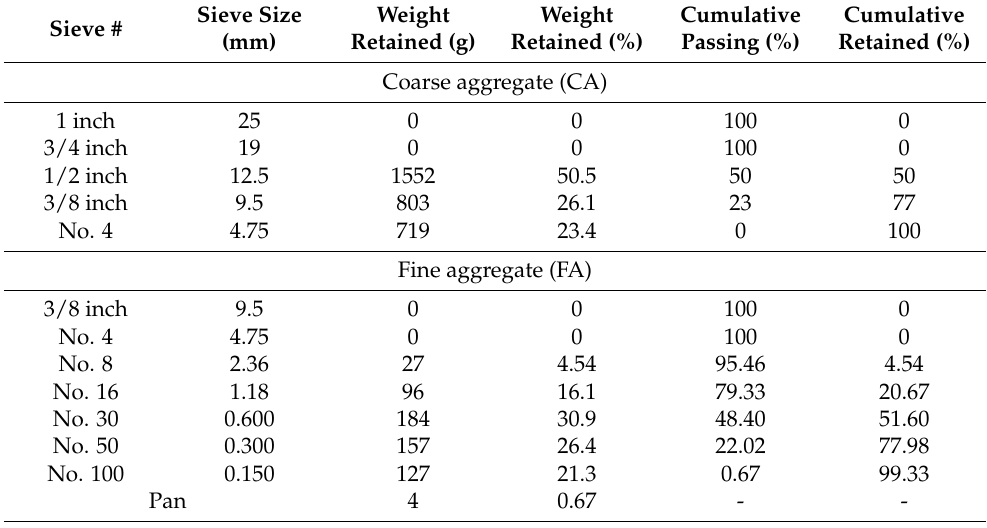
Fineness Modulus of FA ( FM ) = (0 + 4.54 + 20.67 + 51.6 + 77.98 + 99.33)/100 =